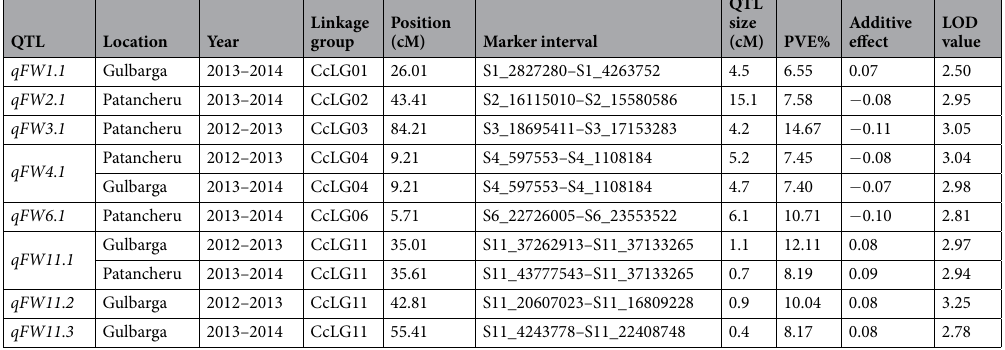
Table 3. Summary on QTL mapping for FW resistance on the genetic map derived from PRIL_A (ICPB 2049 × ICPL 99050).